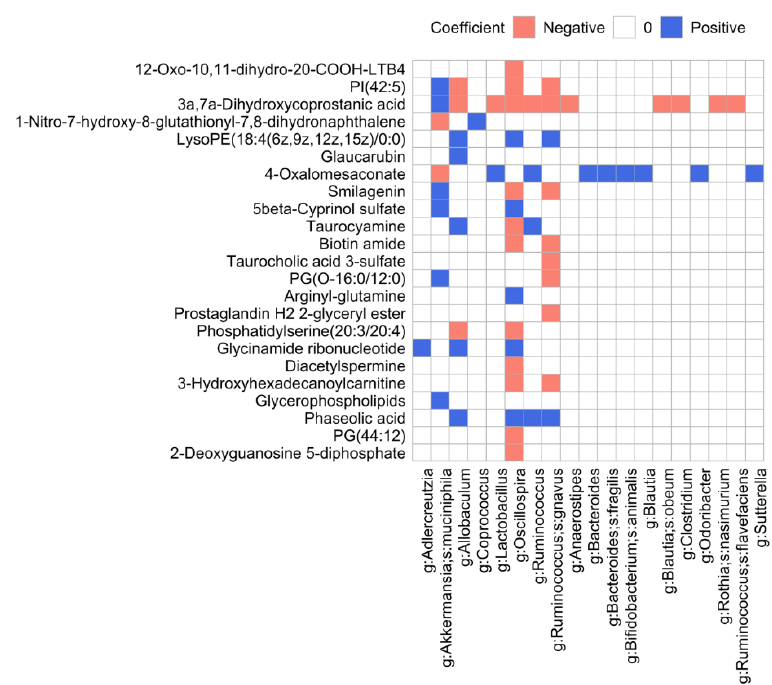
Figure 7. Results of MelonnPan analysis. Comparative analysis of old control and old SFN diet groups using MelonnPan yielded 61 endogenous metabolites showing significant change in abundance, with coefficients of operational taxonomic units in the fitted elastic net models larger than 0.0002. The metabolites shown in the heatmap have no known involvement in drug and plant metabolism.